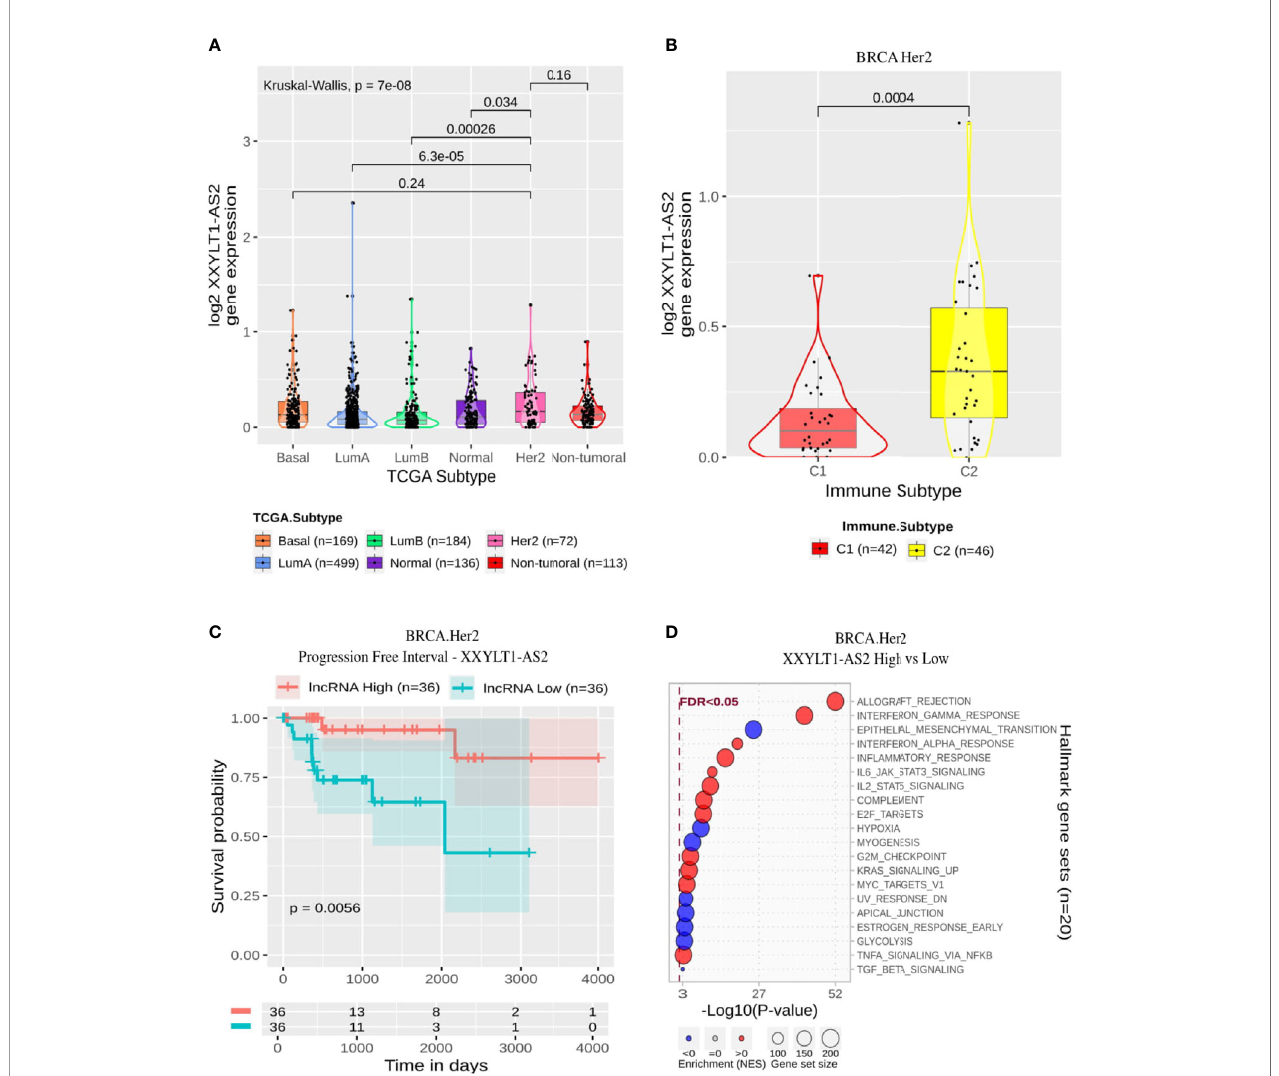
FIGURE 8 | XXYLT1-AS2 panel representation in Her2 subtype. (A) Box-plots representing XXYLT1-AS2 expression among all breast cancer molecular subtypes. The Kruskal-Wallis test (p-value represented in the panel left top position) was used to differentiate expression between groups, followed by the Wilcoxon test (p- values represented emphasizing comparisons between subtypes). (B) Box-plot representing XXYLT1-AS2 in C1, C2, C3, and C4 immune subtypes in Her2 patients. (C) XXYLT1-AS2 progression free interval curves. To de fi ne the two groups, XXYLT1-AS2 ’ s median expression classi fi ed the patients into “ high ” and “ low ” groups. Logrank p-value represented as 0.0056. (D) Enrichment analysis using Hallmarks gene sets. Red circles refer to activation while blue circles to inactivation. In X axis, a p-value scale is represented. The circle size varies according to the number of genes in the identi fi ed gene